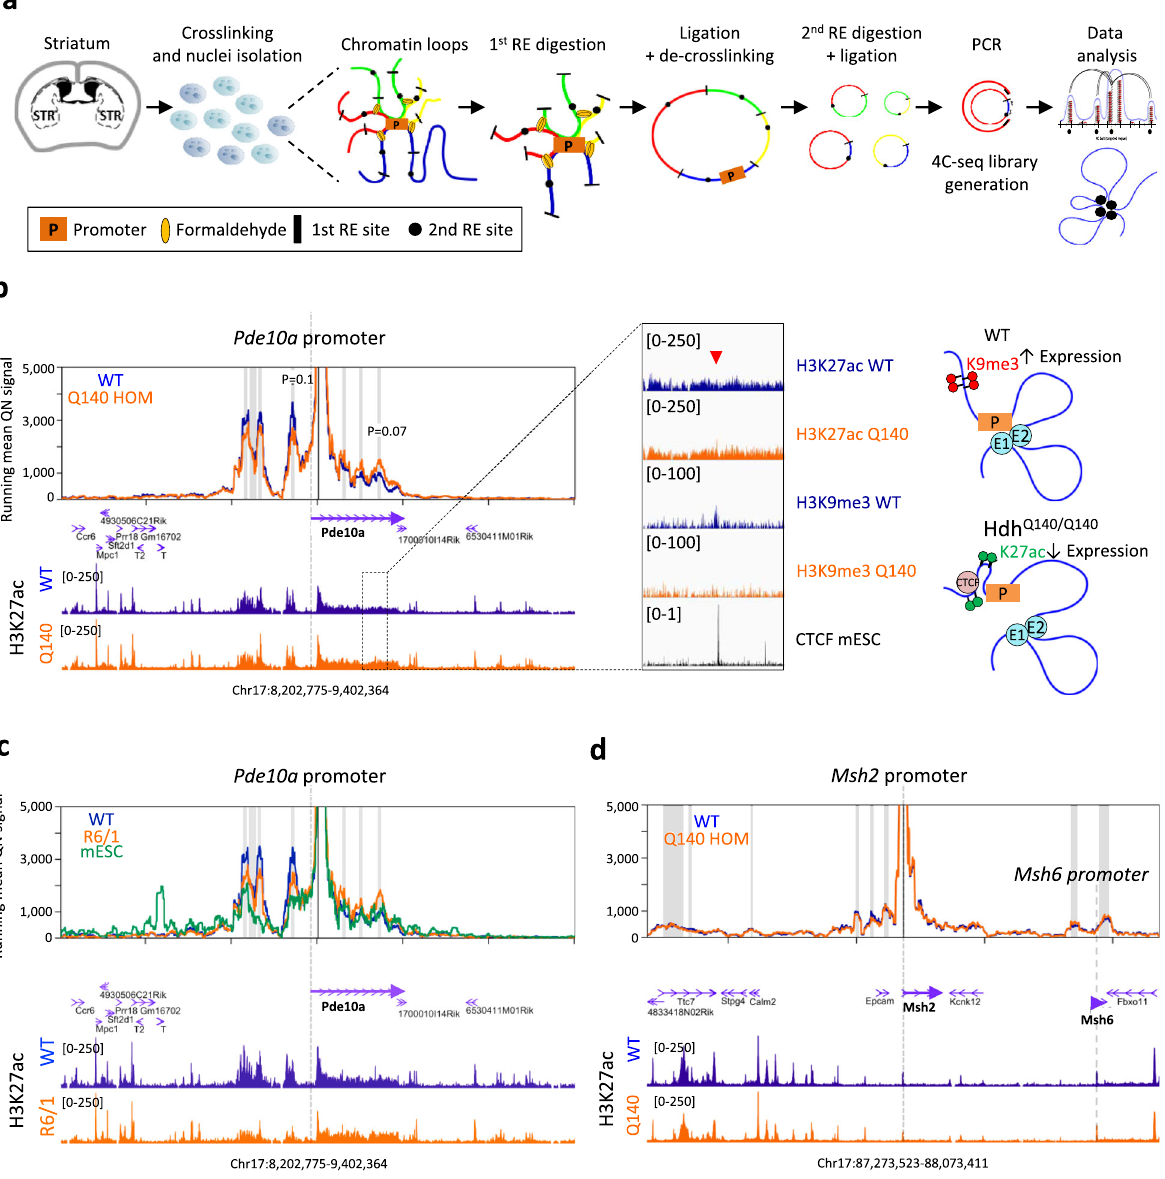
Fig. 4 Chromatin architecture at Pde10a is impaired in the striatum of HD Q140 mice. a Scheme showing 4C-seq technique major steps using mouse striatum. PCR primers speci fi c to each bait can be found in the “ Methods ” section. RE restriction enzyme. b On the left, 4C-seq pro fi les at Pde10a locus using HD Q140 (orange) and WT (blue) mouse striatum at 6 months. The mean of male and female 4C-seq quartile normalized read counts is plotted as the main lane for each condition. Statistical analysis of differential interacting peaks in Q140 vs WT was performed using two-paired t -test, with multiple testing correction using the Benjamini-Hochberg method. P = 0.1 (upstream of Pde10a promoter), P = 0.07 (downstream of Pde10a promoter). Gene annotations are included as well as H3K27ac ChIPseq signals (using ChIPseq data generated in this study on the striatum of Q140 and WT mice at same age). Grey shadows show speci fi c interacting regions. On the middle, zoom into Pde10a intronic region, showing H3K27ac and H3K9me3 levels in WT and Q140 mice striatum together with CTCF enrichment (from CTCF ChIP-seq data generated in mESC). On the right, model to explain chromatin conformational changes at Pde10a locus in HD mouse striatum. c 4C-seq pro fi les at Pde10a locus generated using HD R6/1 (orange) and WT (blue) mouse striatum at 14 weeks of age and using mESC (green). Gene annotations and H3K27ac ChIPseq signals 3 are included. Grey shadows show speci fi c interacting regions. d 4C-seq pro fi les at Msh2 locus using Q140 (orange) and WT (blue) striatum at 6 months. The mean of male and female 4C-seq quartile normalized read counts is plotted as the main lane for each condition. Gene annotations and H3K27ac ChIPseq signals are included. Grey shadows show speci fi c interacting regions. Msh6 promoter is annotated to highlight the distal chromatin loop formed with Msh2 convergent CTCF pair.